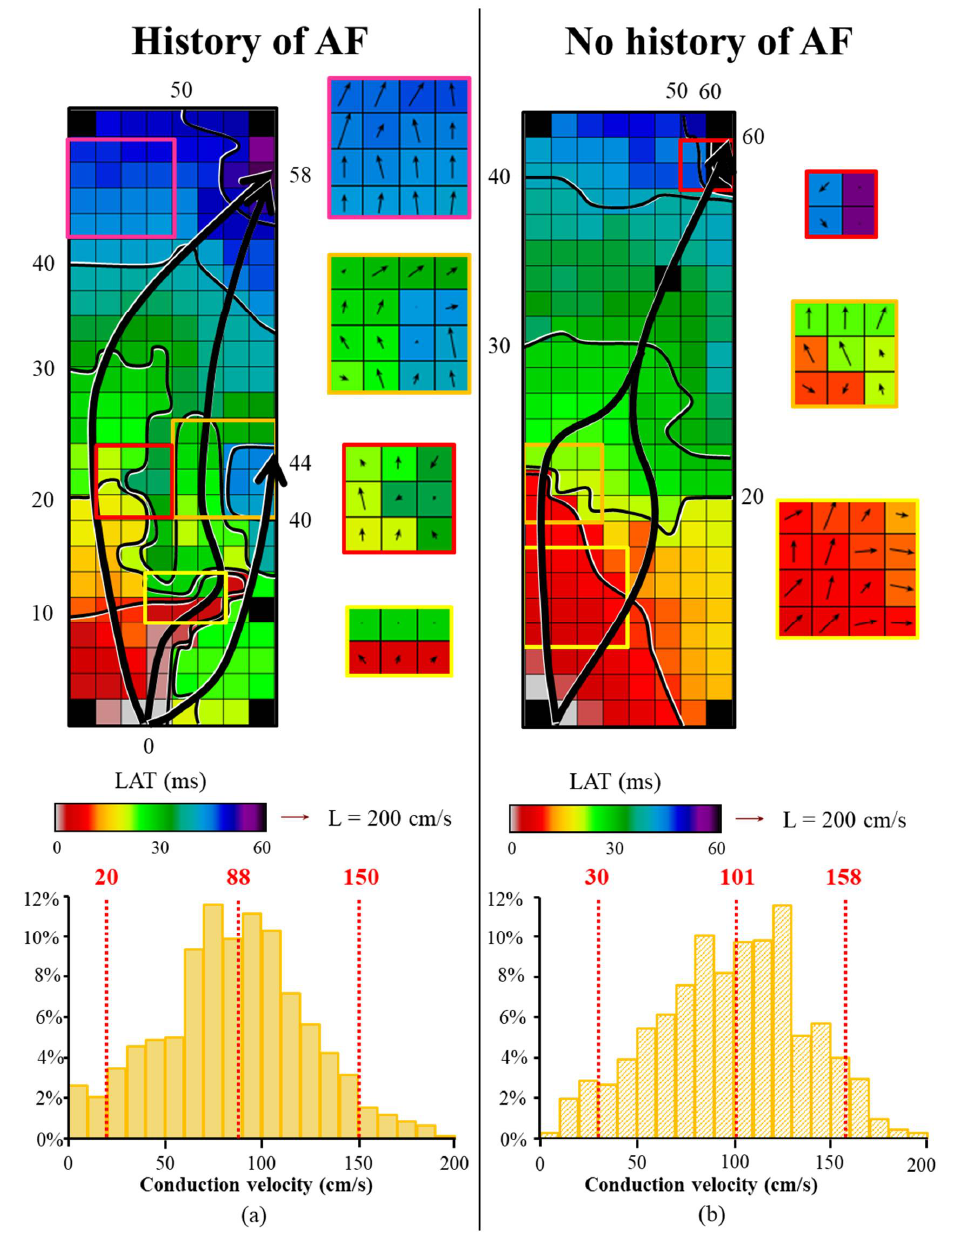
Figure 3. Color-coded activation maps and corresponding CV histograms at BB of a patient with and without a history of AF. The upper panel shows two examples of a color-coded activation maps at BB obtained from a patient with a history of AF ( a ) and a patient without a history of AF ( b ). Corresponding CV maps are depicted next to the activation map. CV vectors are depicted per electrode. In the patient with AF, a large area of slowing of conduction is present in the lower part of the activation map, represented by crowding of isochrones. The colored boxes indicate smooth wavefront propagation (pink rectangle) and local conduction heterogeneities (yellow, red and orange rectangles). In the patient without AF, the sinus rhythm wavefront encounters only some small areas of conduction delay (orange and red rectangles). Isochrones (black lines) drawn at 10 ms. The black arrows indicates the main wave direction. Lower panel: corresponding CV histograms of the patient with AF ( a ) and without AF ( b ) recorded at BB. The dashed lines represent the 5th, 50th and 95th percentiles of the relative frequency distribution of CVs. cm/s = centimeter/second; ms = milliseconds; BB = Bachmann’s bundle; CV = conduction velocity; LAT = local activation time.